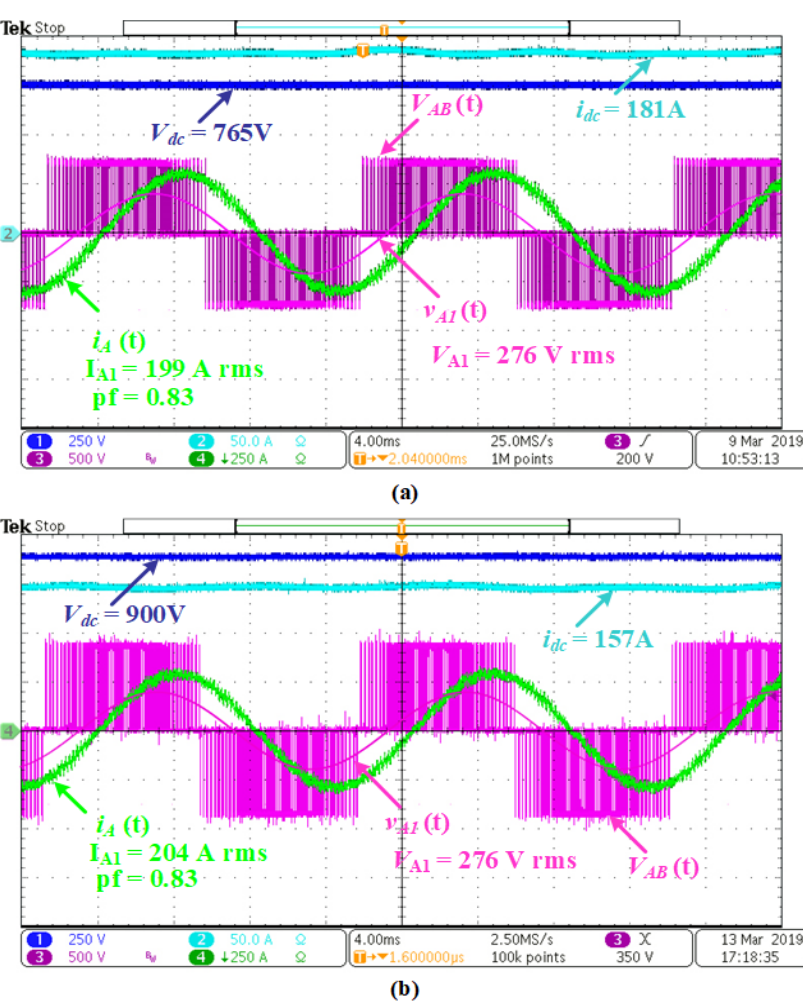
Figure 14. Input DC current, I dc , and DC link voltage, V dc , and AC output voltage, v AB , and current, i A , waveforms corresponding to f s = 60 Hz, f sw = 10 kHz as recorded by Tektronix MDO3034 oscilloscope at a sampling rate of 1 MS/s/channel while ( a ) the traction inverter is delivering 165 kVA to the traction motor at V dc = 765 V, and ( b ) the traction inverter is delivering 169 kVA to the traction motor at V dc = 900 V.